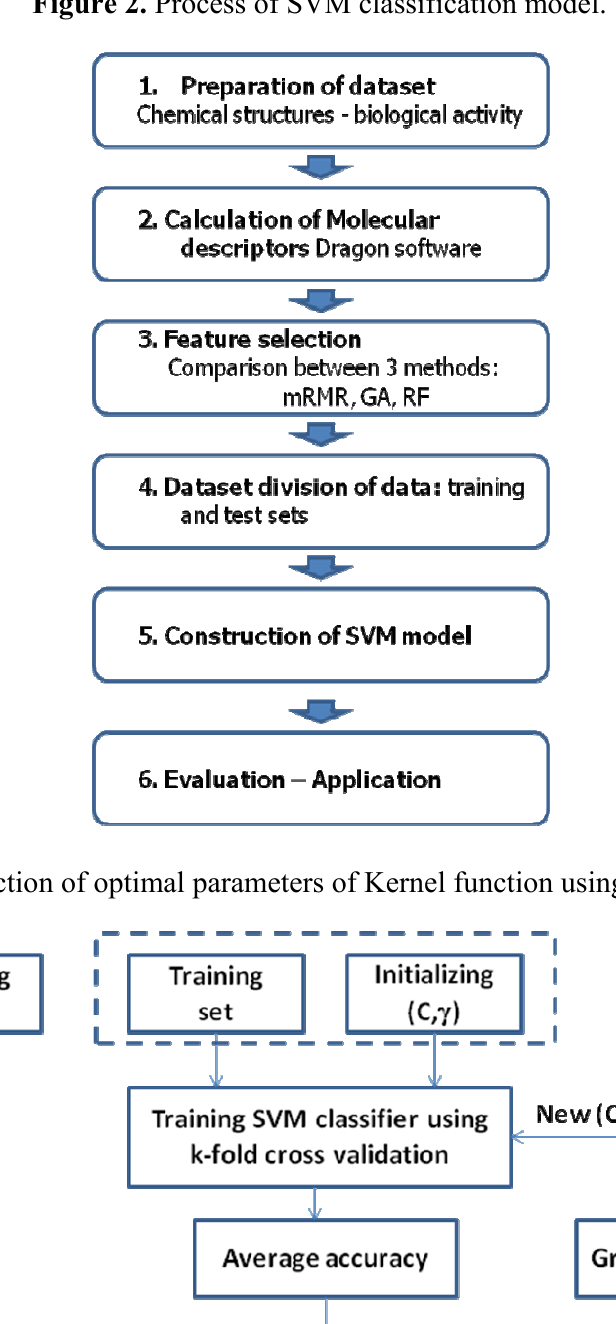
Figure 2. Process of SVM classification model.